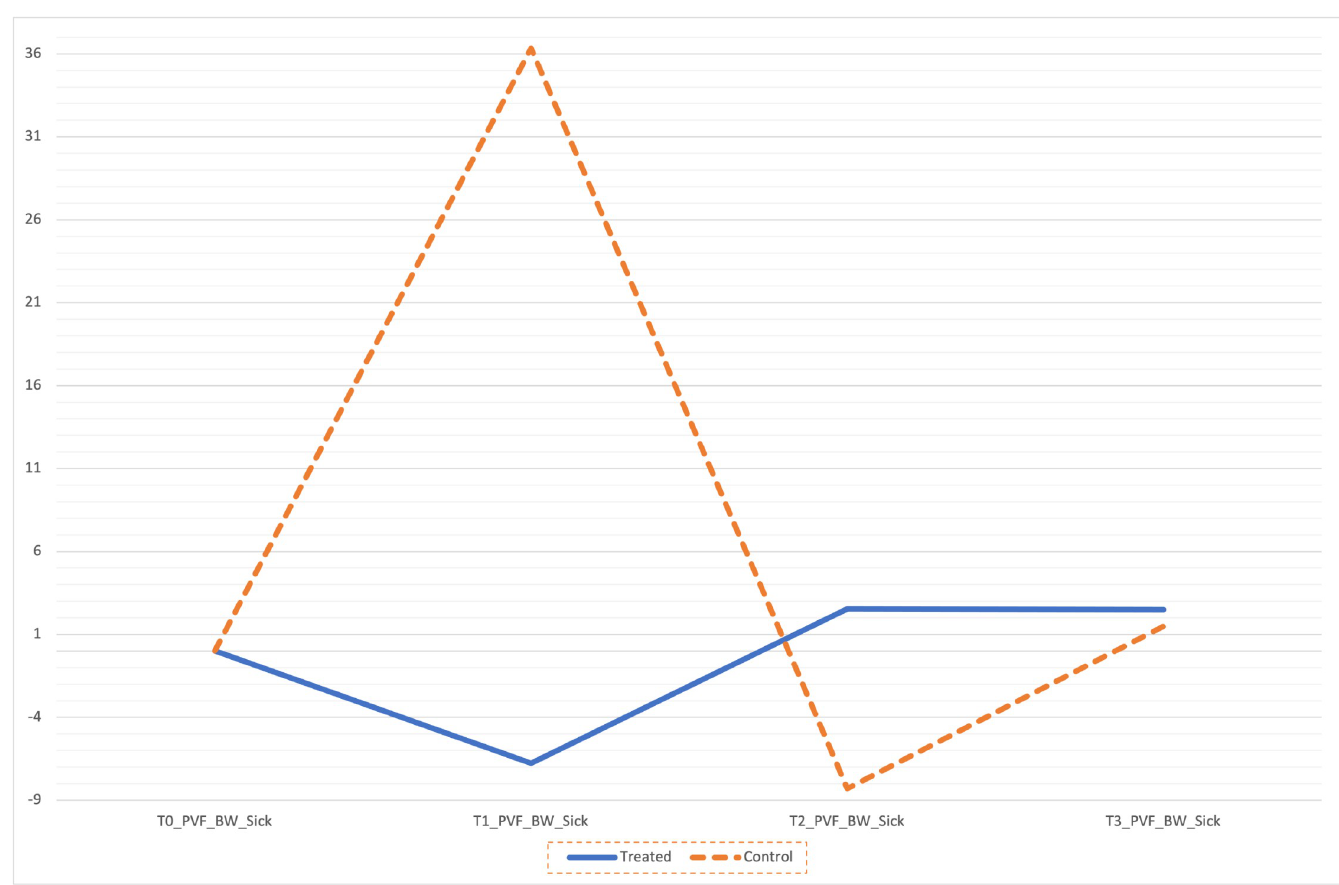
Fig 1. Percentage increase in PVF%BW over time between two